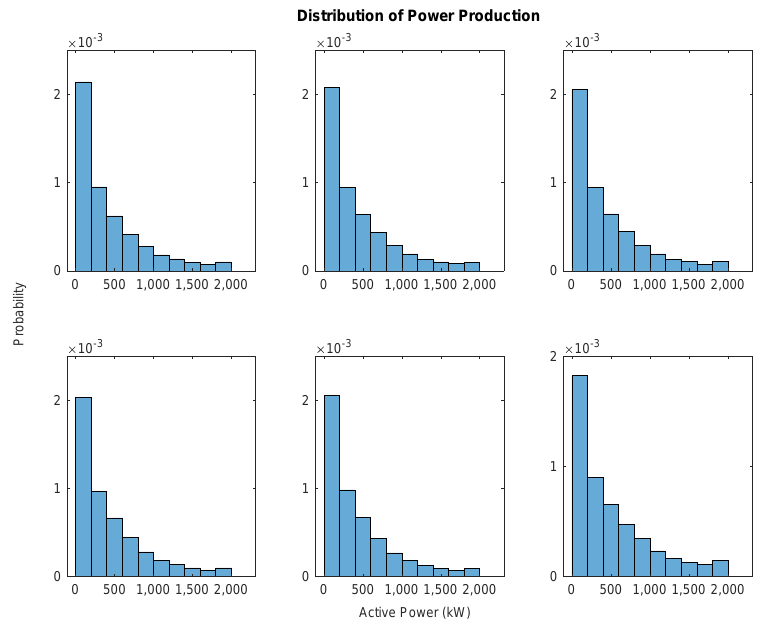
Figure 2. Empirical distribution function for each turbine.